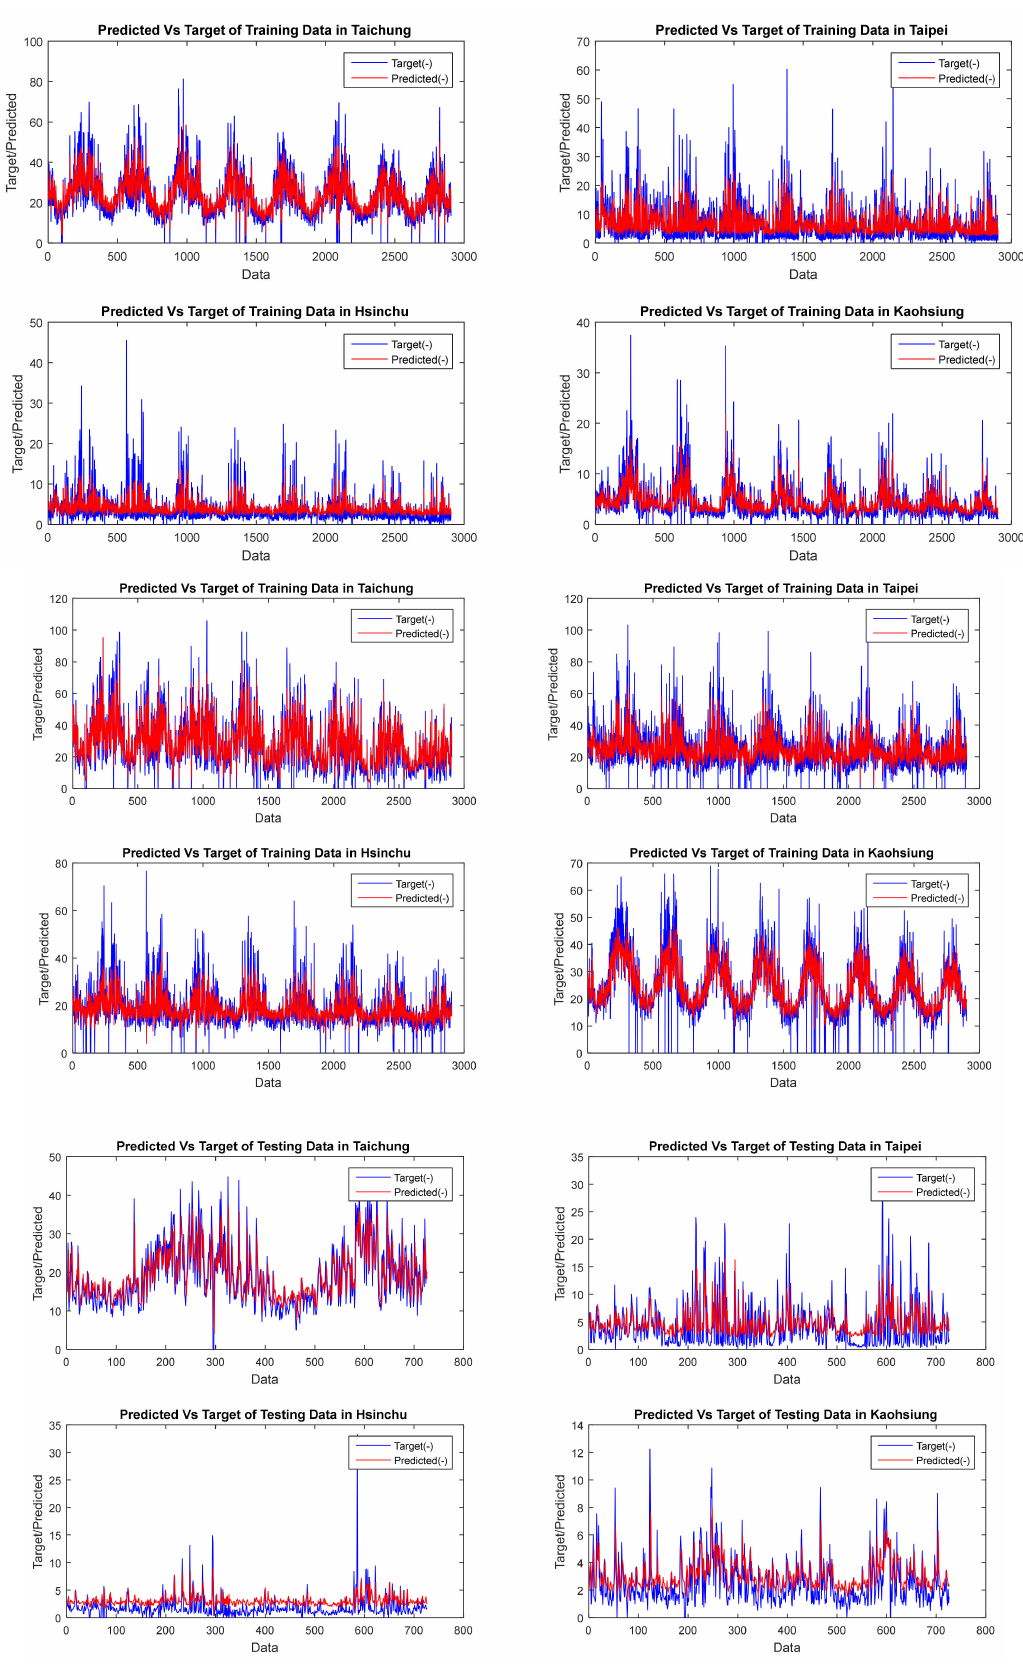
Figure 4. NOx GSTAR(2) CFNN